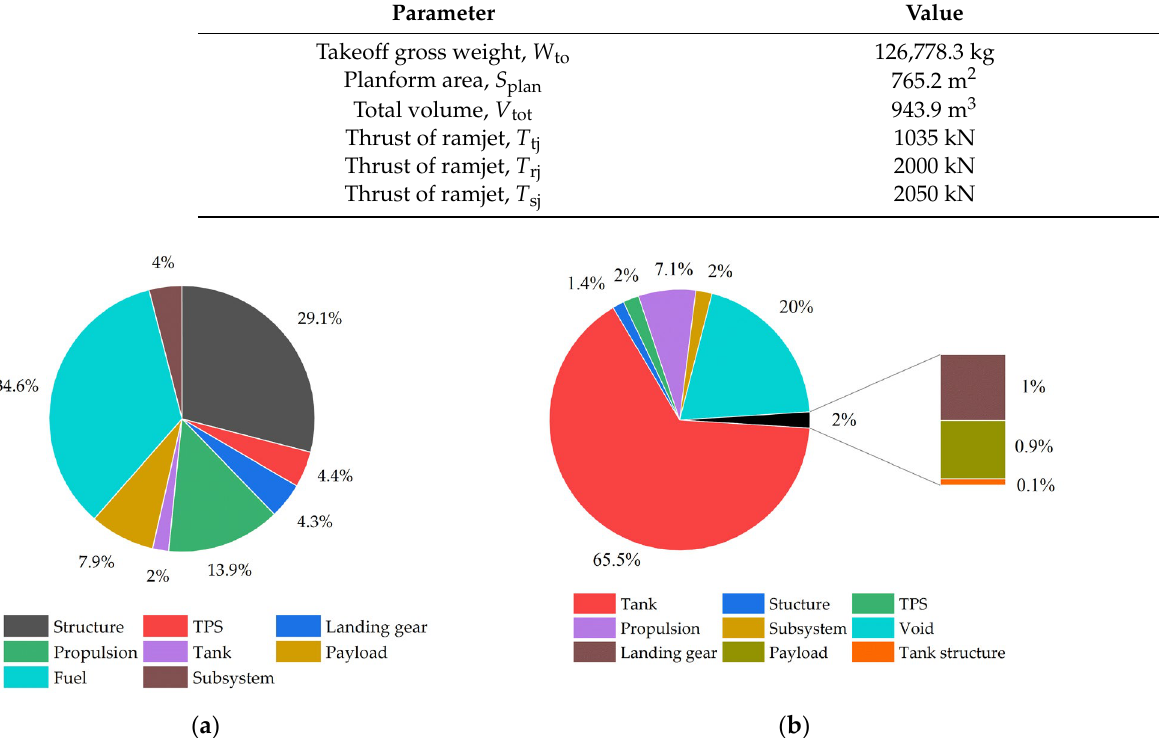
Figure 8. Mass and volume distributions of the illustrative aircraft. ( a ) Mass distribution; ( b ) volume distribution.